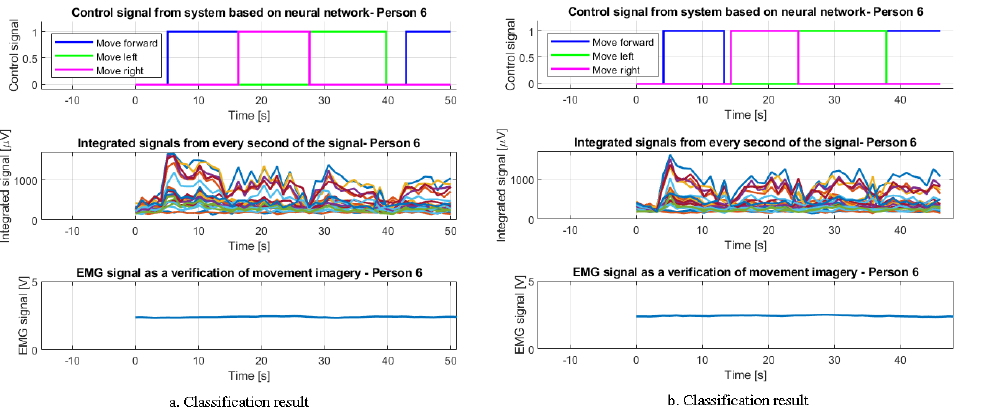
Figure 23. Observation of the signal classification and verification results—Person